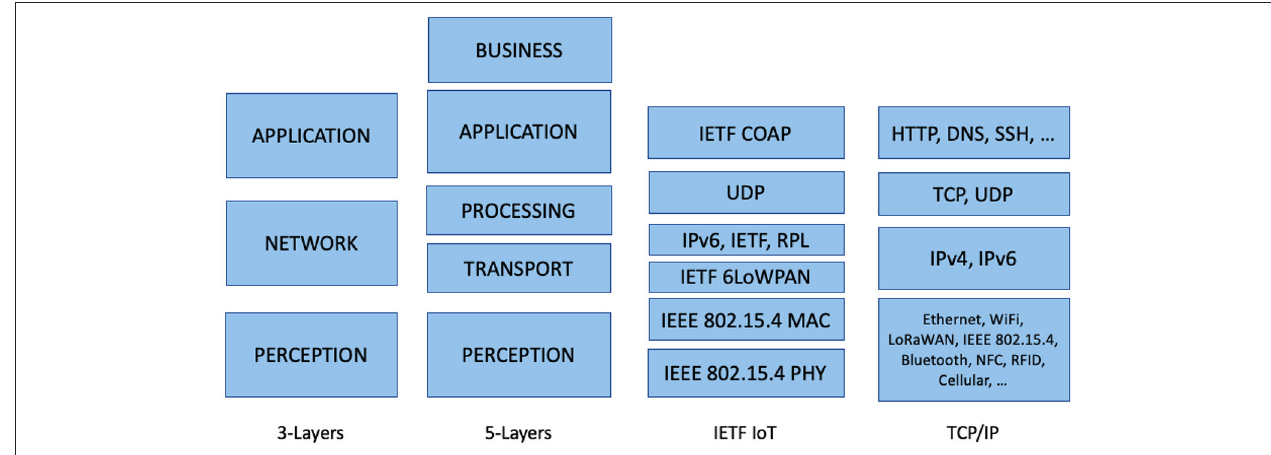
FIGURE 1 | IoT architectures and protocol